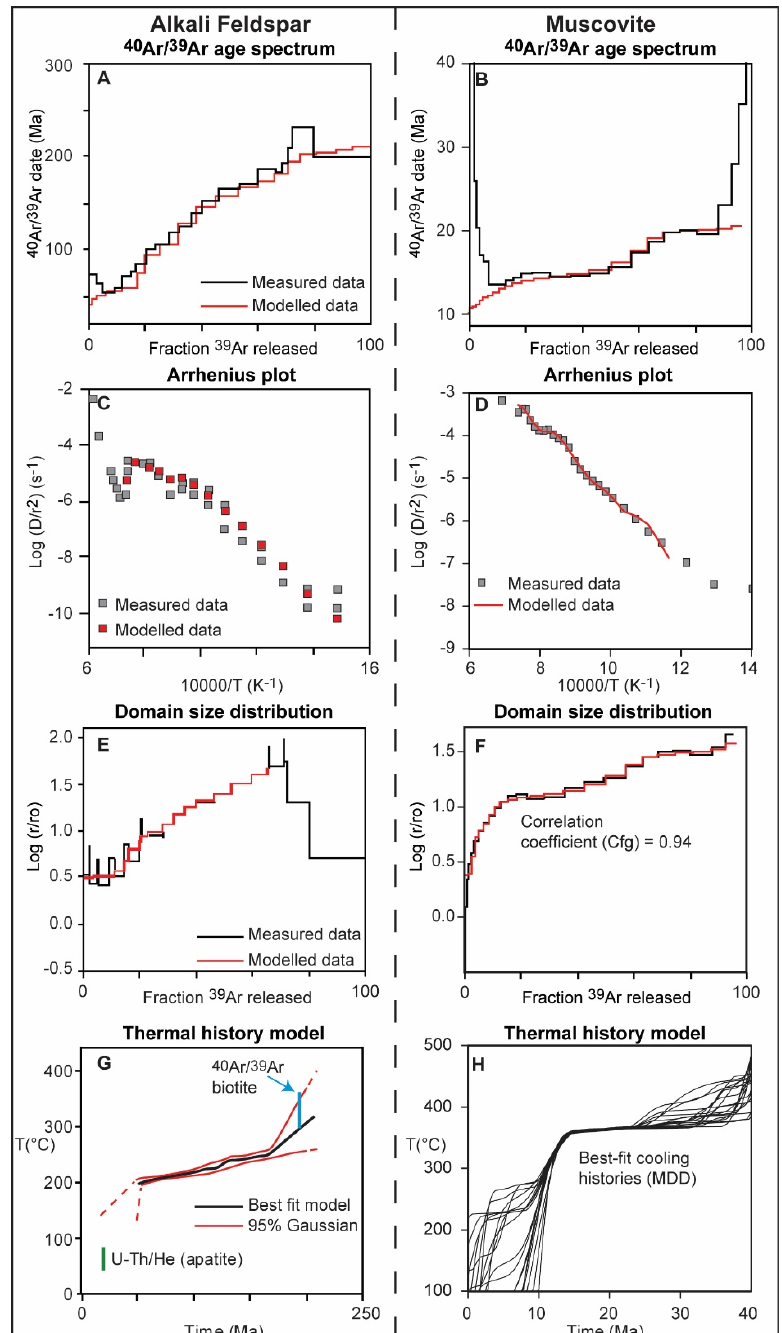
Figure 1. Multi-domain diffusion modeling of argon isotope data acquired from alkali feldspar [22] and muscovite [32]. ( A , B ) The age spectrum (distribution of radiogenic 40 Ar relative to reactor produced 39 Ar K ), which is interpreted to be the function of the t-T history of the analysed grain(s). ( C , D ) The Arrhenius plot, which is a function of the heating schedule and the grain(s) structure. The activation energy (268 kJ/mol) used to construct the Arrhenius plot for the muscovite is taken